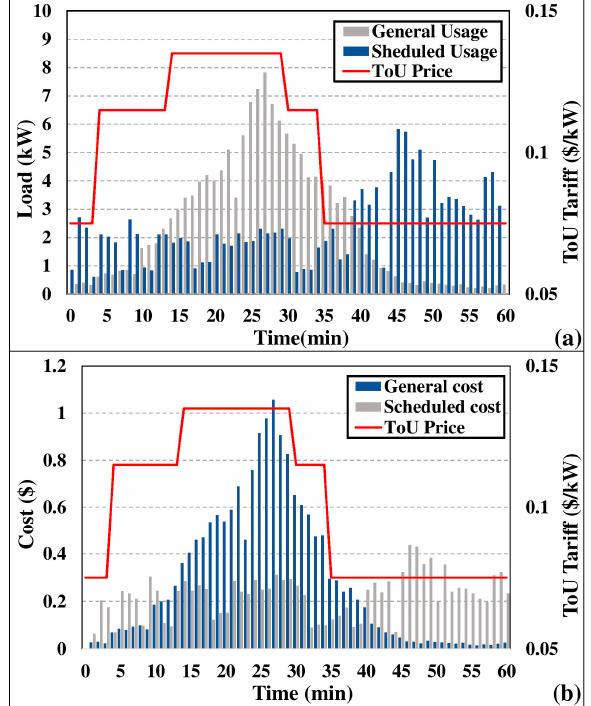
Figure 8. Consumption load profile and cost profile ( a ) consumption load profile of general appliance operation and scheduled appliance operation; ( b ) consumption cost profile of general appliance operation and scheduled appliance operation.